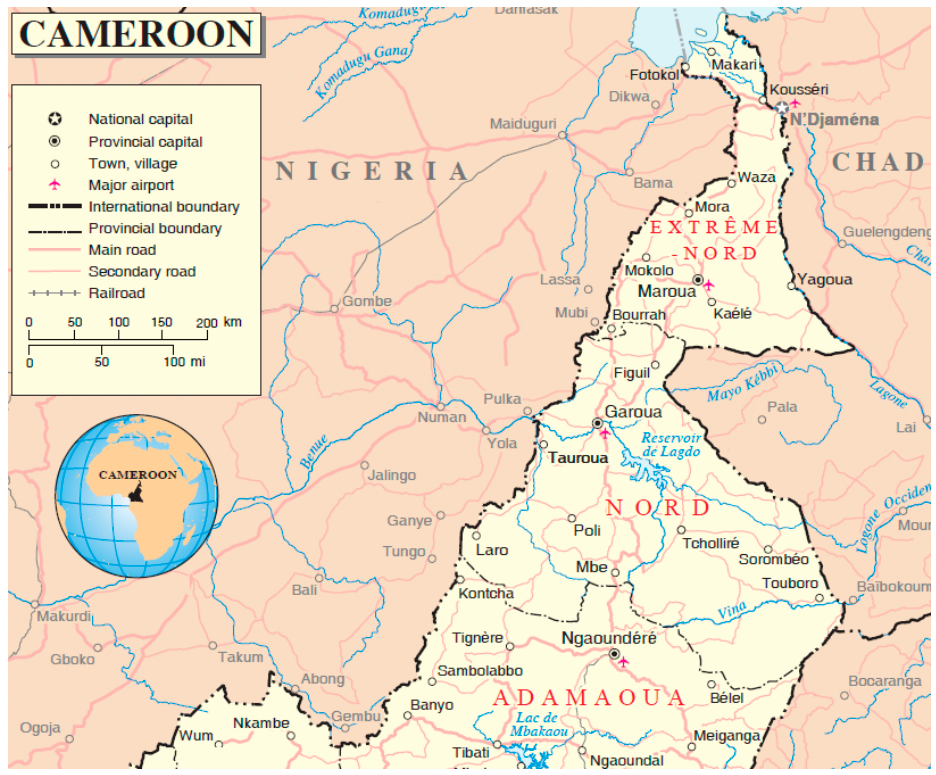
Figure 4. Map of the study area.